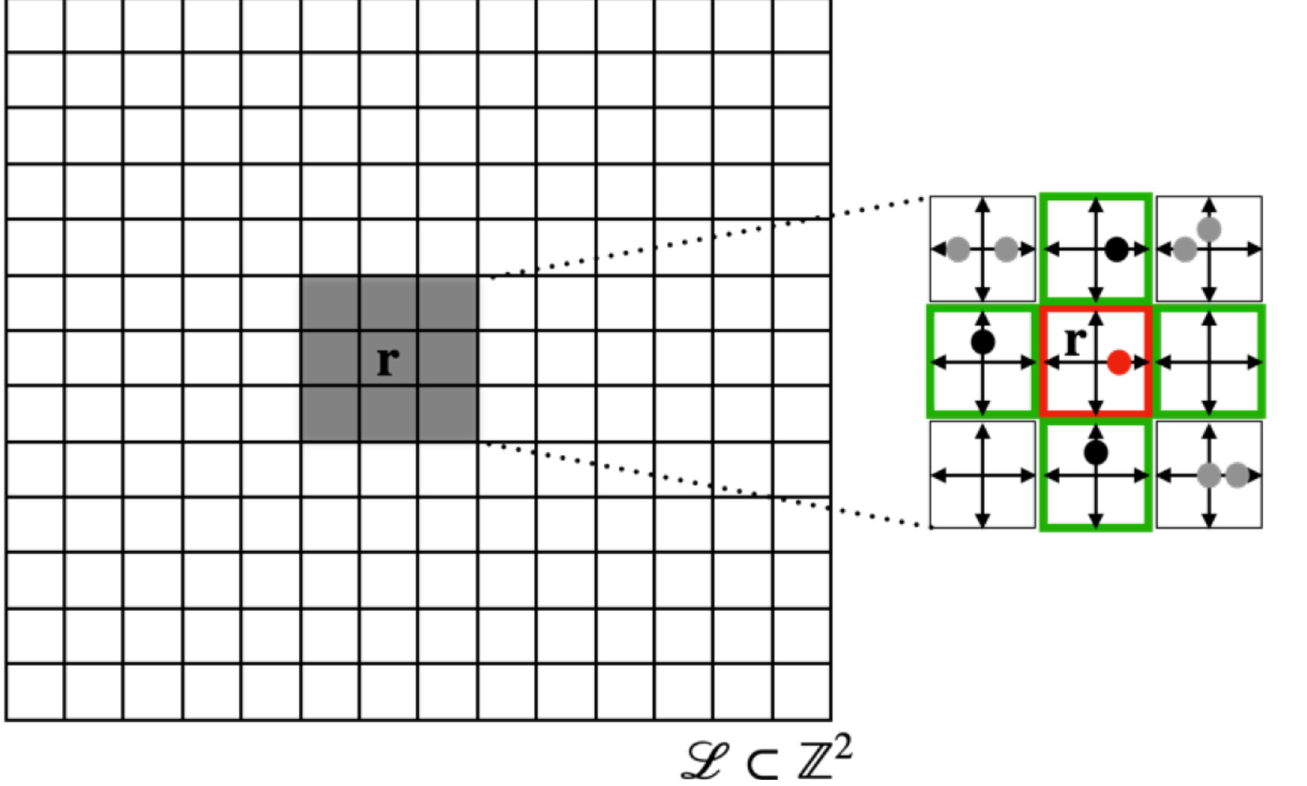
Fig 2. Lattice and neighbourhood in the BIO-LGCA. Example of square lattice (left). The node state is represented by the occupation of velocity channels (right); in the example, there are four velocity channels c 1 , c 2 , c 3 , c 4 , corresponding to the lattice directions, and one “rest channel” c 5 . Filled dots denote the presence of a cell in the respective velocity channel; right: von Neumann neighbourhood (green) of the red node. Black dots represent interaction partners of the red dot. Gray dots lie outside of the interaction neighbourhood and do not interact with the red dot.